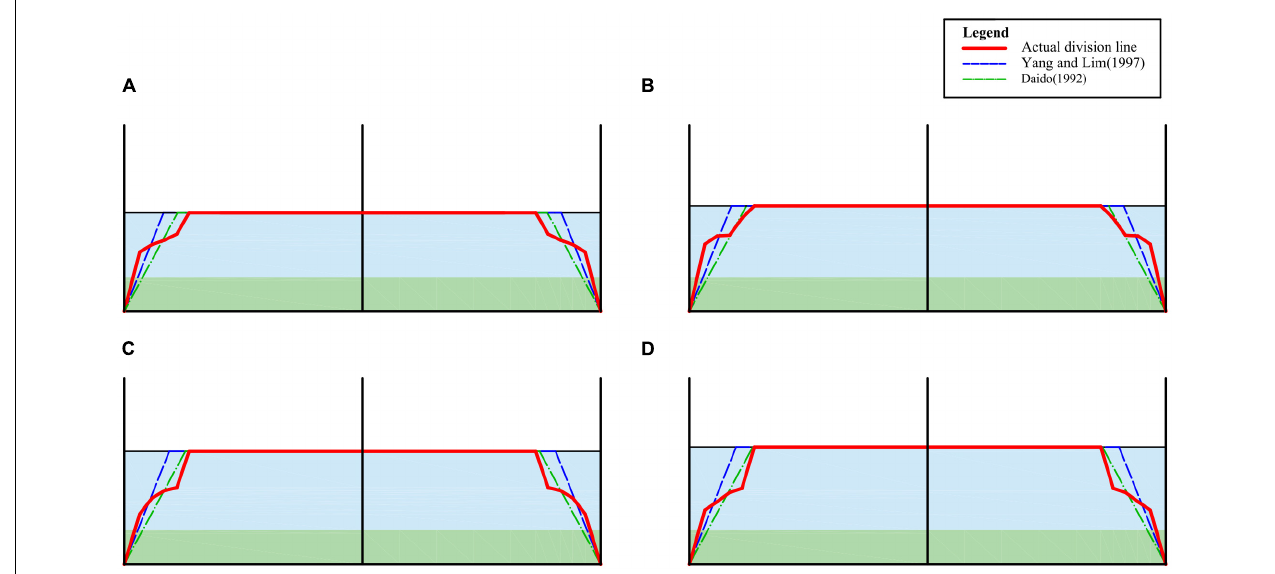
FIGURE 8 | Velocity dividing line of open channel with flexible vegetation. (A) 90 m 3 /h, (B) 100 m 3 /h, (C) 110 m 3 /h, (D) 120 m 3